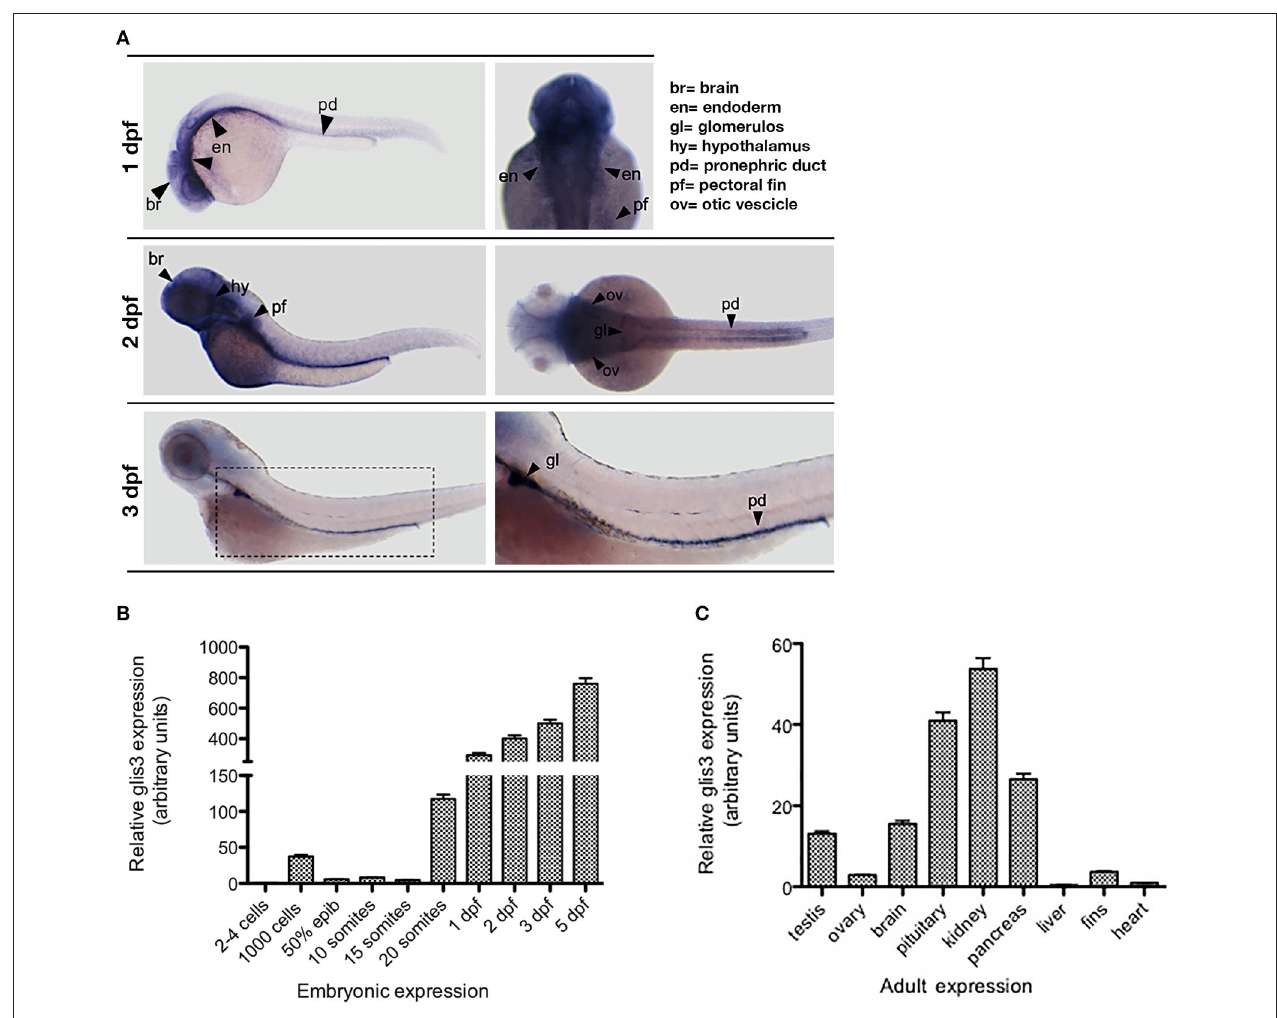
FIGURE 2 | Ontogenetic pattern of glis3 expression in zebrafish. (A) Tissue specific expression of glis3 , at different developmental stages, analyzed by ISH using glis3 antisense riboprobe followed by NBT/BCIP staining, as previously described ( 29). Images are representative of three experiments (30 embryos each). (B,C) qRT-PCR of glis3 relative mRNA expression during embryonic development and adult tissues. Total RNA is extracted from pools of 50 embryos/stage and from 3 adults, respectively. cDNA synthesis and qRT-PCR following standard procedures ( 28). Experiments are performed in triplicate and results are expressed by Mean ±